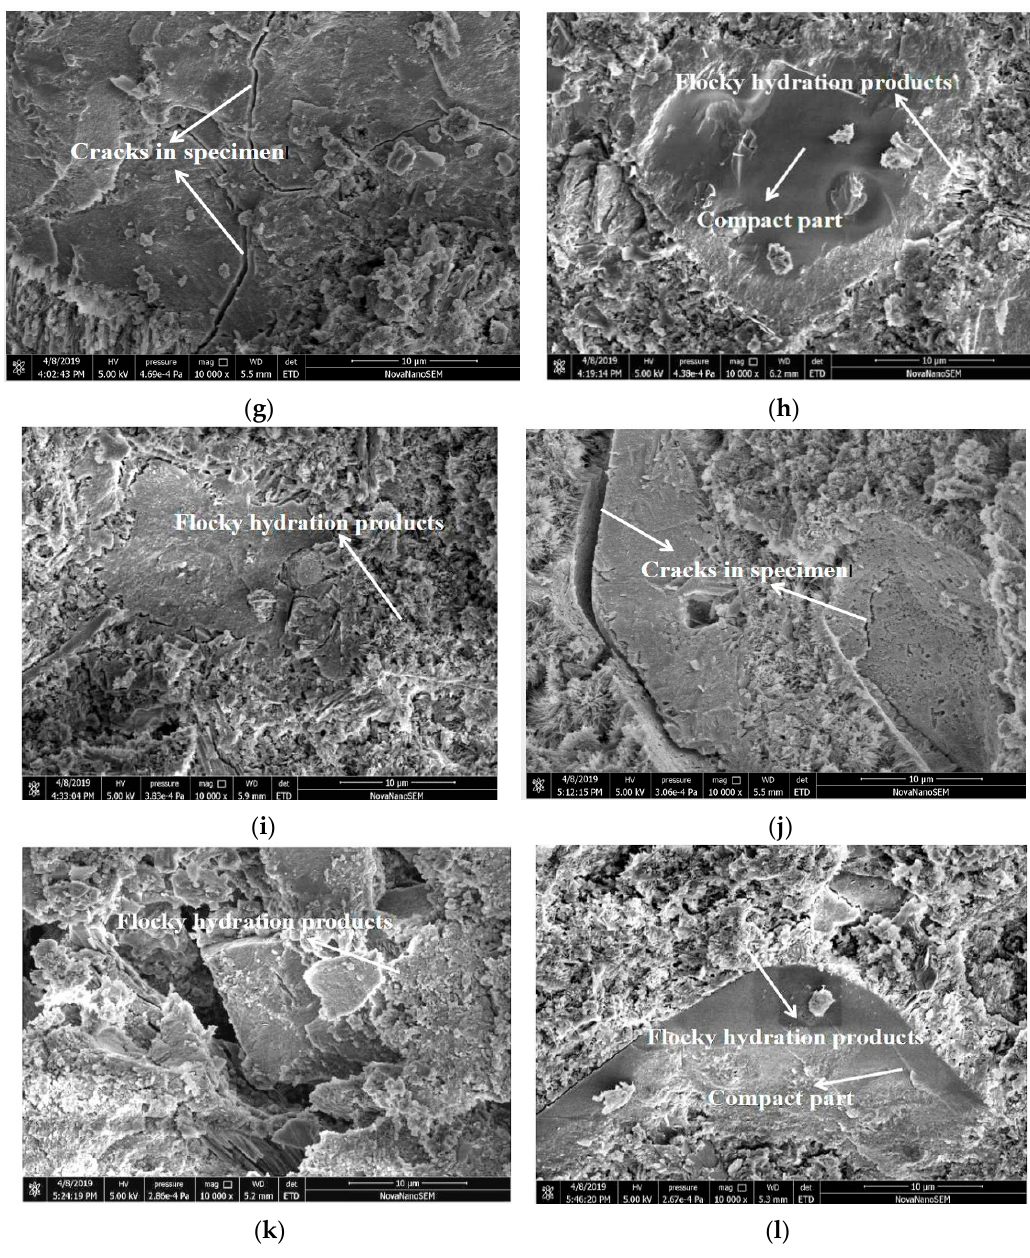
Figure 11. SEM micrographs of specimens with RHA: ( a ) RHA-1 (10000); ( b ) RHA-2 (10000); ( c ) RHA- 3 (10000); ( d ) RHA-4 (10000); ( e ) RHA-5 (10000); ( f ) RHA-6 (10000); ( g ) RHA-7(10000); ( h ) RHA-8 (10000); ( i ) RHA-9 (10000); ( j ) RHA-10 (10000); ( k ) RHA-11 (10000); ( l ) RHA-12 (10000).